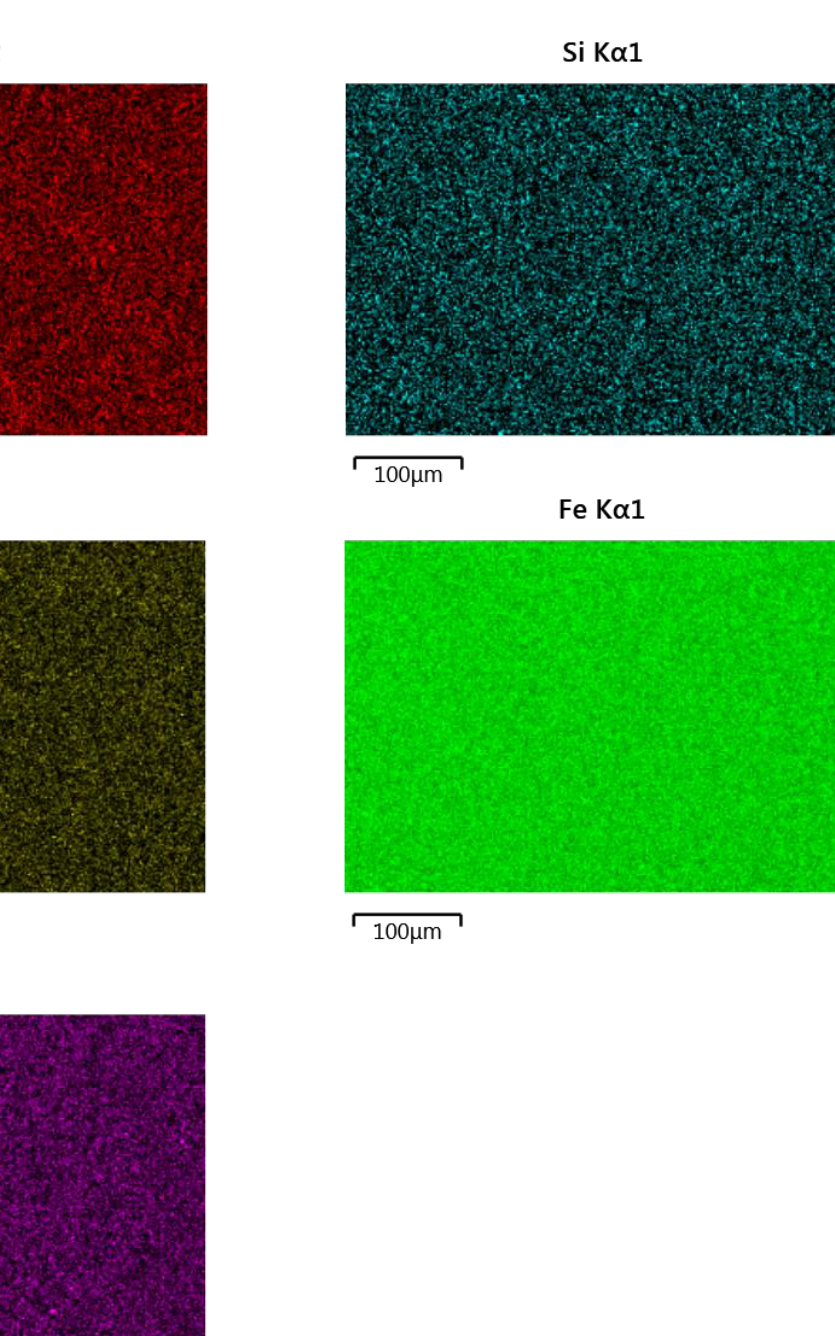
Figure 14. EDS spectrum registered in the HAZ of a sample cladded at 2400 W laser power at a position close to the interface (HAZ1 + HAZ2 subareas -upper photo).